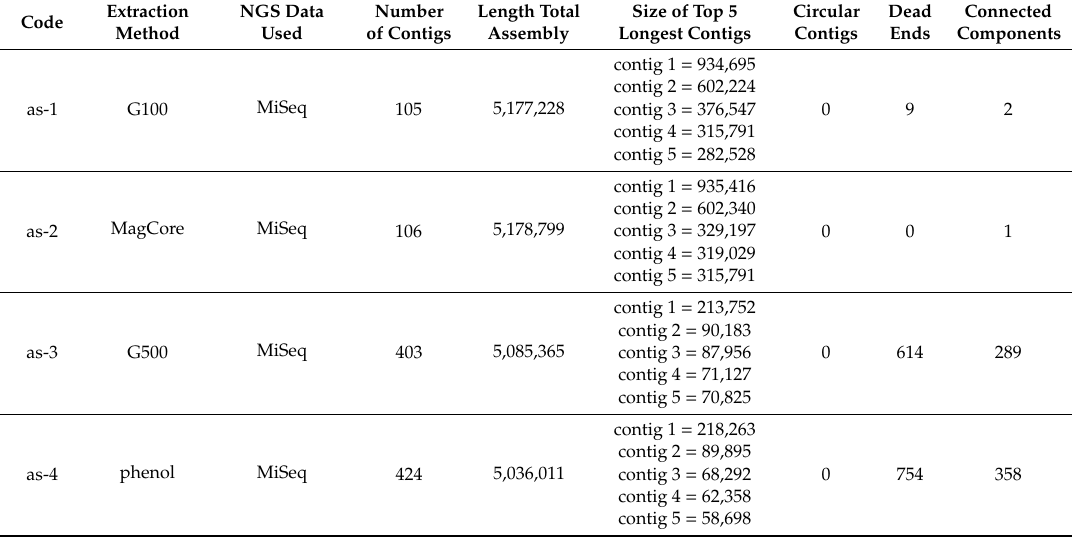
Figure 3. Visualization with Bandage of the MiSeq, MinION and hybrid assemblies performed on the whole-genome and plasmid DNA extractions (G100, MagCore, G500, phenol and phenol-ampli) of Salmonella isolate S15BD05371 (extractions 3–5 and 7–8 (Table 1), assemblies 1–15 (Table 2)). Each line represents a contig, and a red line is in higher coverage compared to the other contigs within the same assembly. * There was not enough MinION read coverage to complete the assembly of phenol-ampli with only MinION reads. Table 2. Assembly statistics of Salmonella isolate S15BD05371 with MiSeq and MinION reads and a combination